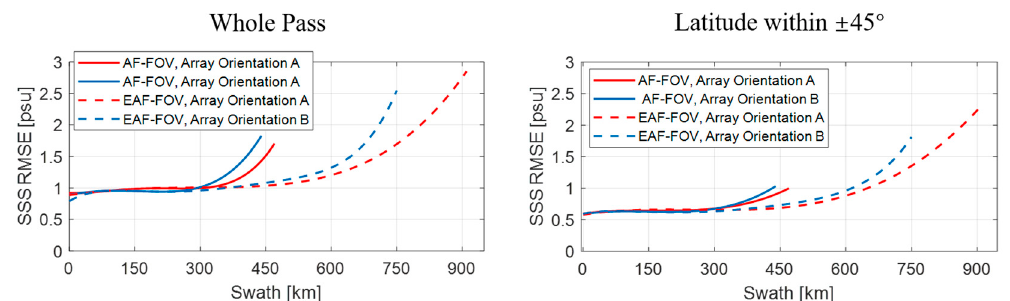
Figure 14. Illustration of the fitting results of the SSS root mean square errors (RMSE) variation versus the distance to the swath center, considering case 2, i.e., of 1 °C. SST error and 2 m/s WS error in the SSS retrieval. The results of array orientations A and B are shown as red and blue lines, and the results for the AF-FOV and EAF-FOV are shown as solid and dashed lines, respectively. The subplots in the left and right panels present the results of the whole pass and of part of the pass with latitude within ±45°. Table 2. The statistics of SSS retrieval accuracy of the whole pass for di ff erent array orientations of case 1 and case